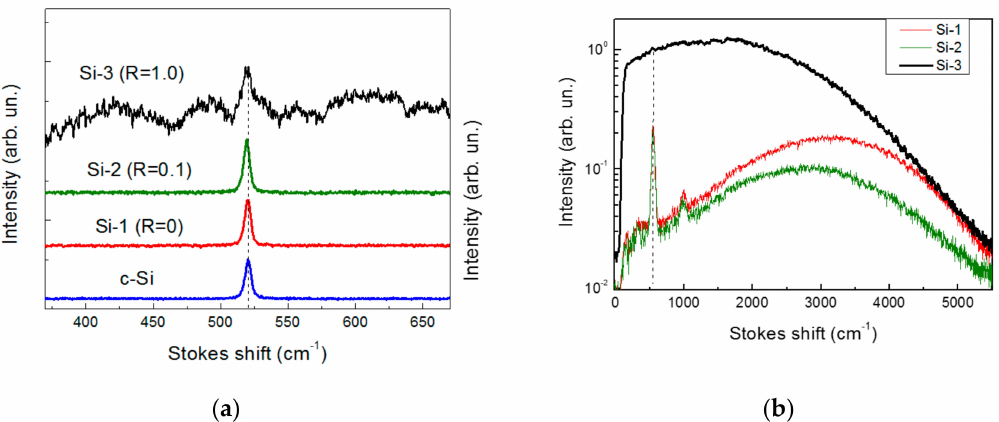
Figure 3. ( a ) Raman spectra of nc-Si sample obtained at di ff erent ratio of helium to nitrogen pressures, as well as one for c-Si substrate; ( b ) Raman and PL spectra measured in a wide range. Vertical dashed lines indicate the Raman line position (520.5 cm − 1 ) for c-Si.